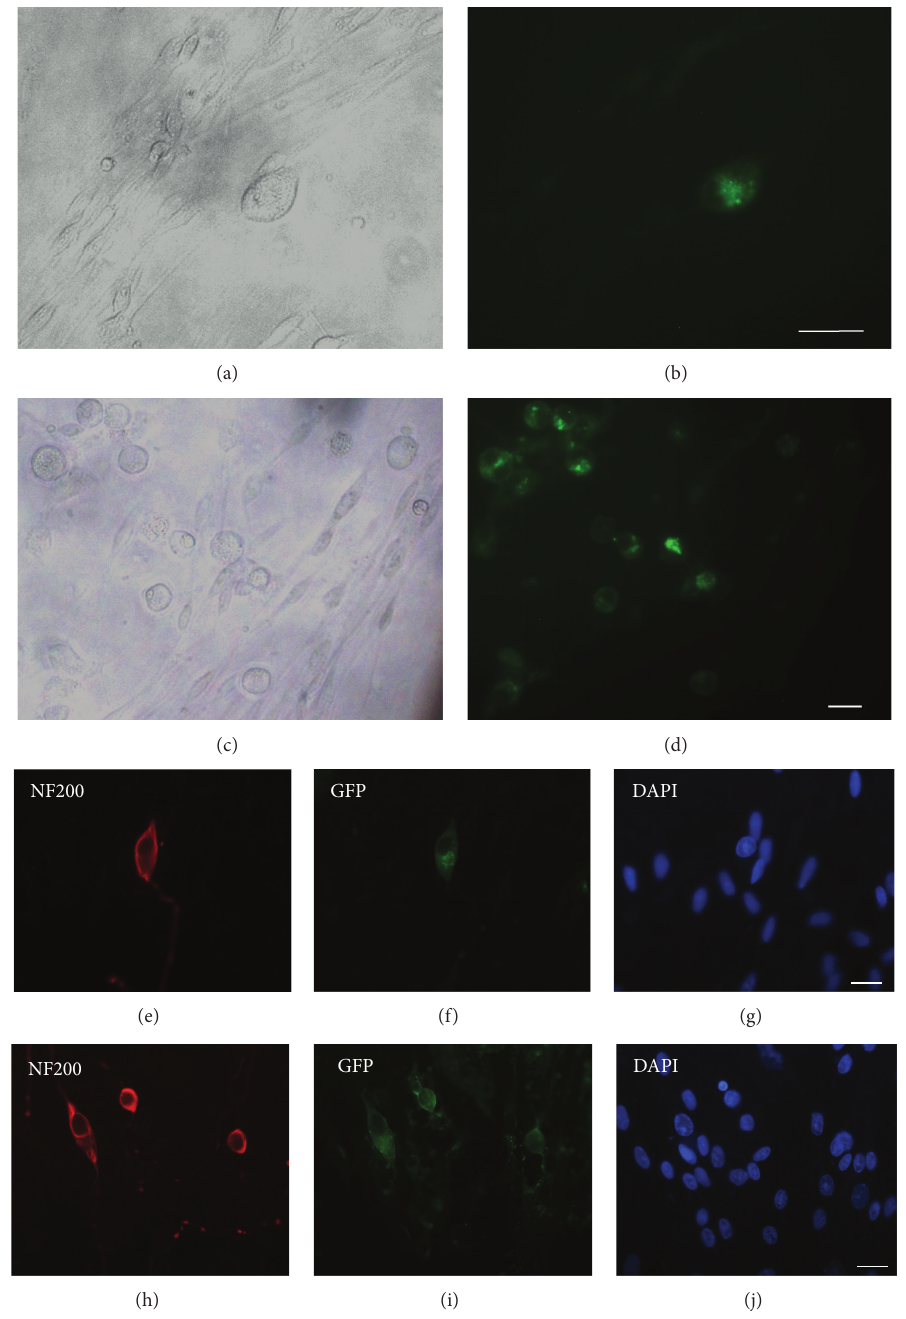
Figure 2: Pattern of HSV-1 infection in VGN cultures. VGN cultures following lytic infection with HSV-1/UL46-GFP using phase contrast microscopy ((a), (c)) and fluorescent photomicrographs ((b), (d)). Double labeling of intrinsic GFP fluorescence ((f), (i)) and NF200 immunostaining of neurons ((e), (h)). Scale bar, 20